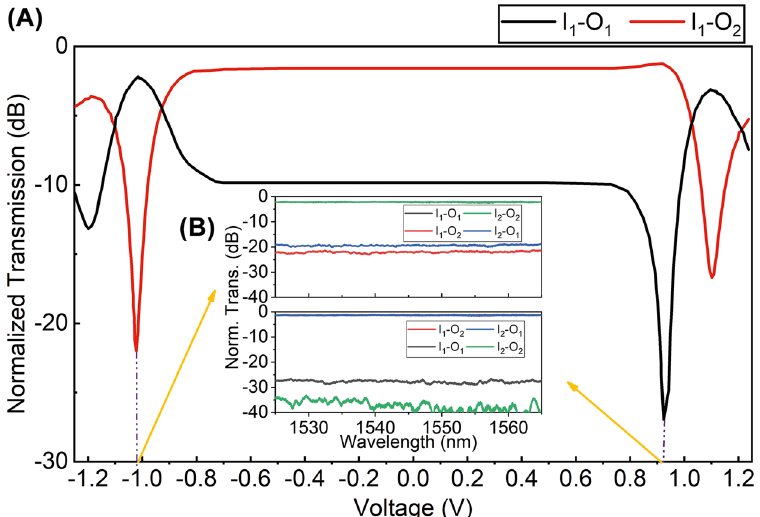
Figure 4: The performance of the OSU. (A) Measured output power of the OSU vs. applied voltage on the electrode S. (B) The normalized transmission spectra for both